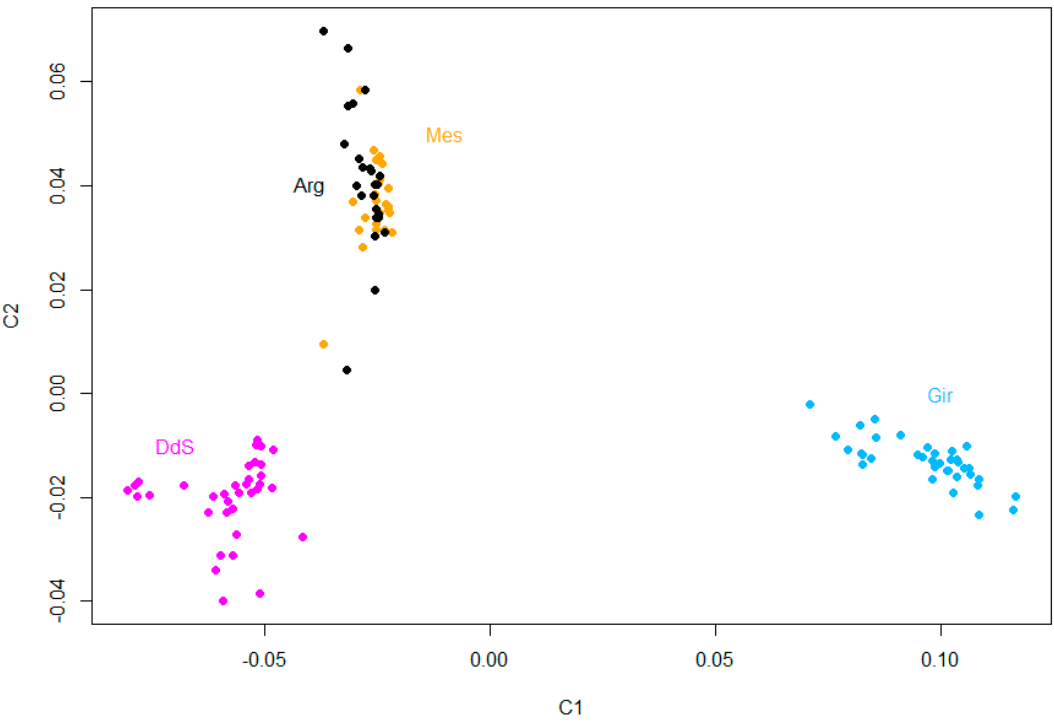
Figure 1. MDS plot of the Sicilian goat breeds. Arg = Argentata; DdS = Derivata di Siria; Gir = Girgentana; Mes = Messinese.